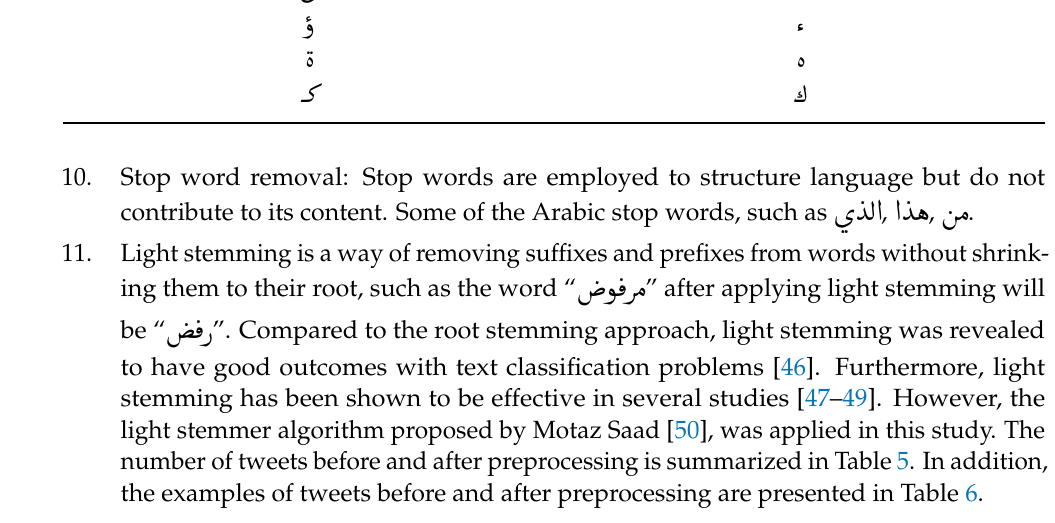
Table 5. The size of the collected tweets before and after the cleaning process. Files